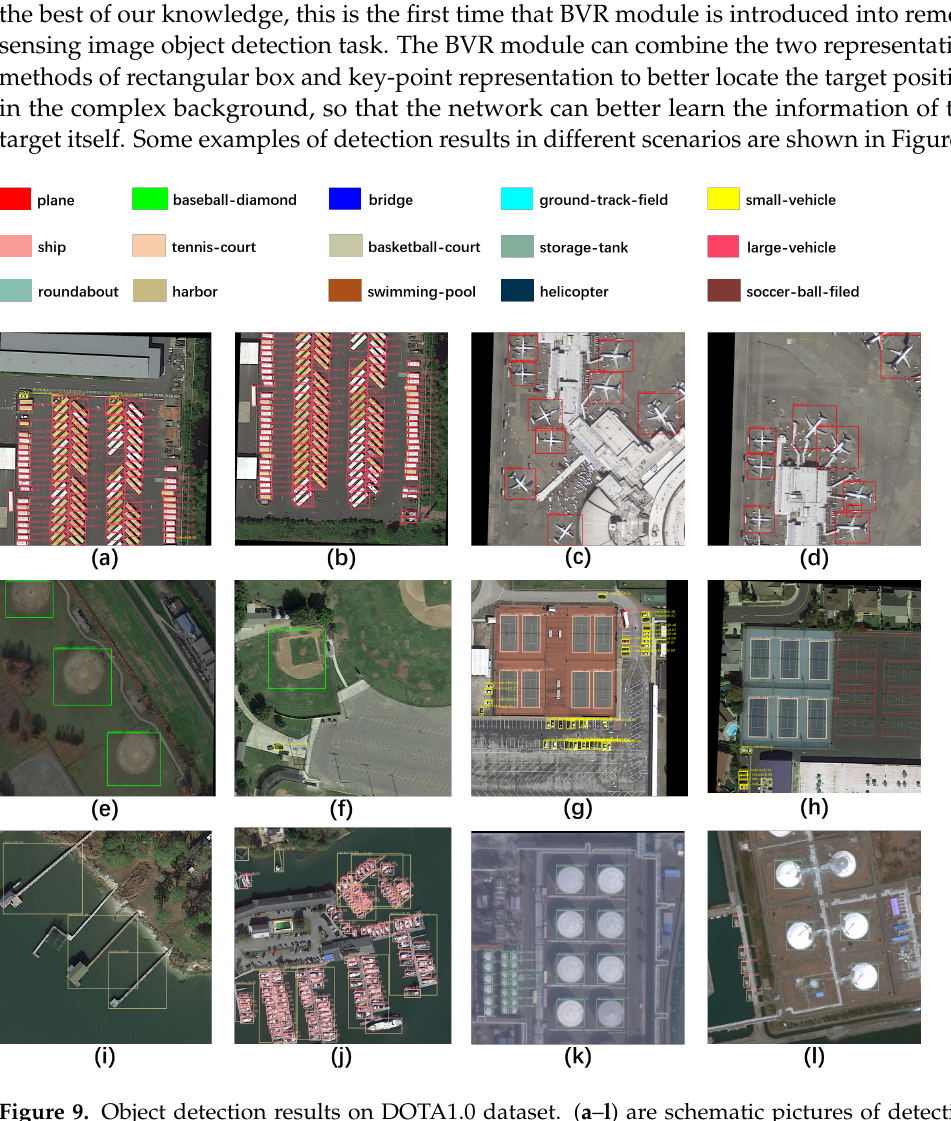
Figure 9. Object detection results on DOTA1.0 dataset. ( a – l ) are schematic pictures of detection results in different